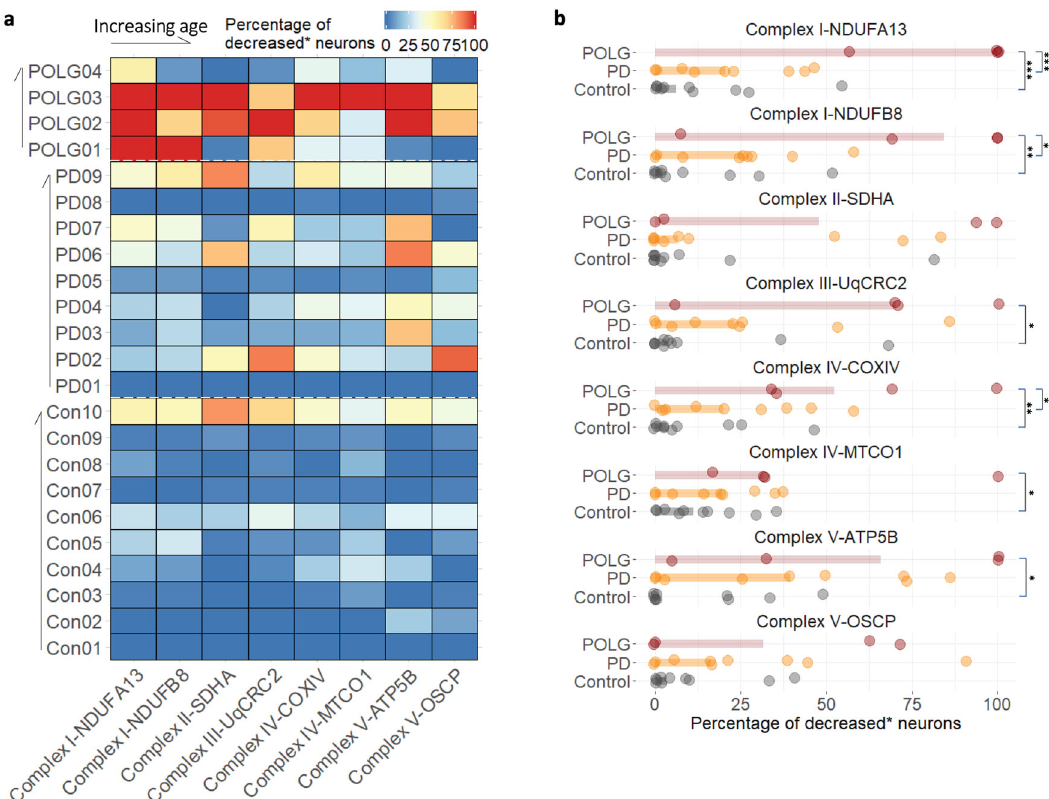
Fig. 3 Pro fi ling of mitochondrial OxPhos protein de fi ciency in disease and control cases. The percentage of neurons showing a decreased level of protein expression (*decreased-below the lower limit of the 80% prediction interval of the control regression) was calculated for each individual case. This percentage was presented for each protein target in a heatmap ( a ) and compared between groups ( b ). Bars show the median per group. The difference within each pair was analysed using a Mann – Whitney test ( p value, *<0.05, **<0.01,